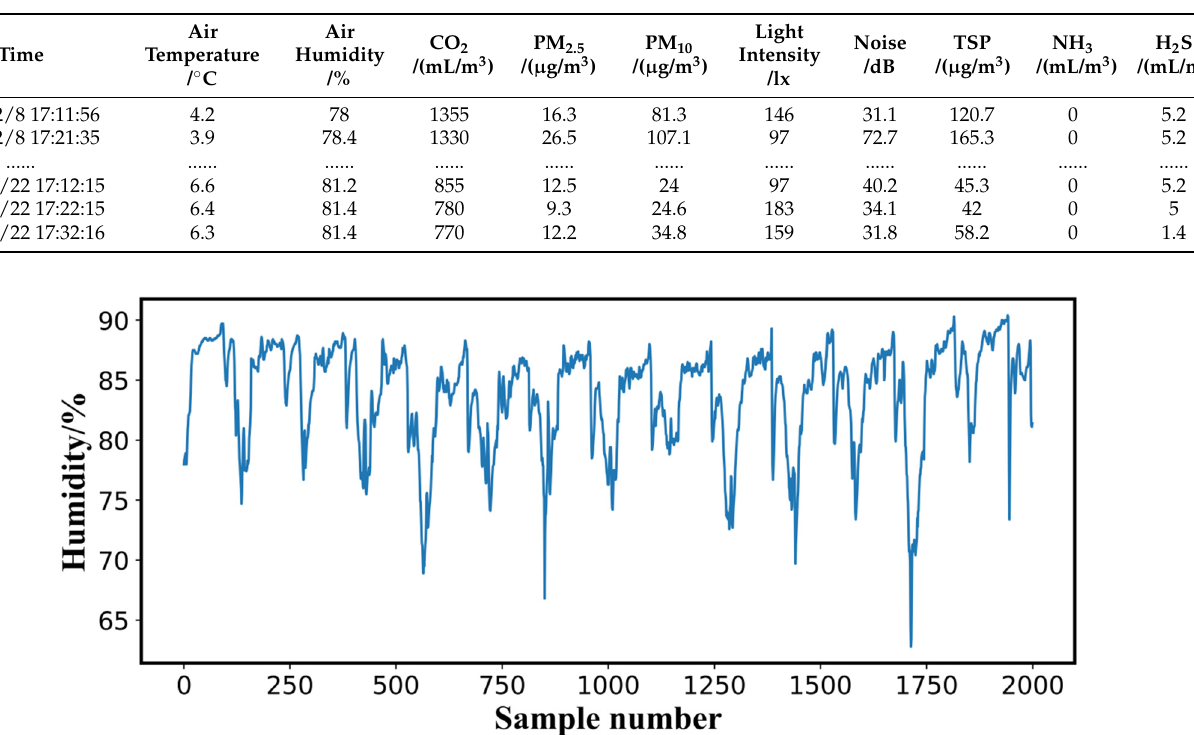
Figure 2. Original nonlinear curve of the values of air